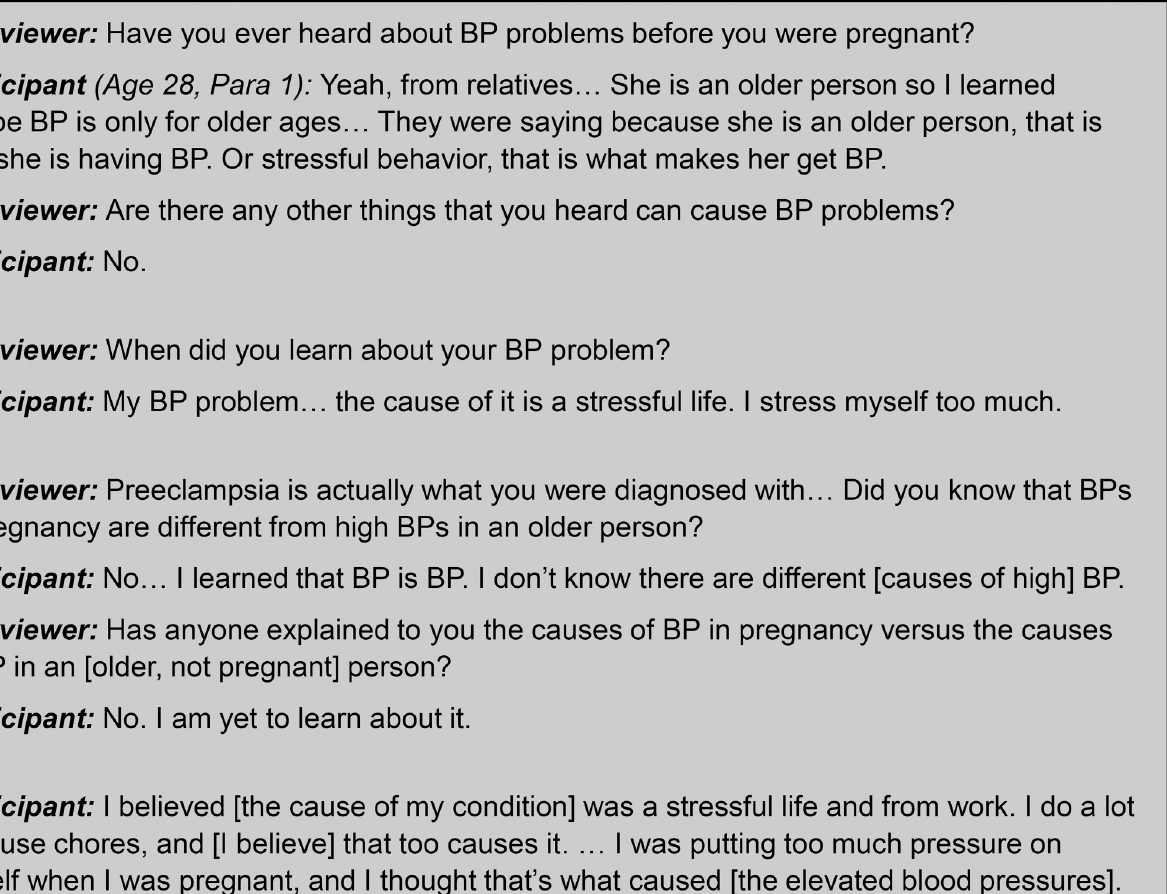
Fig 2. Interview excerpt demonstrating diagnostic